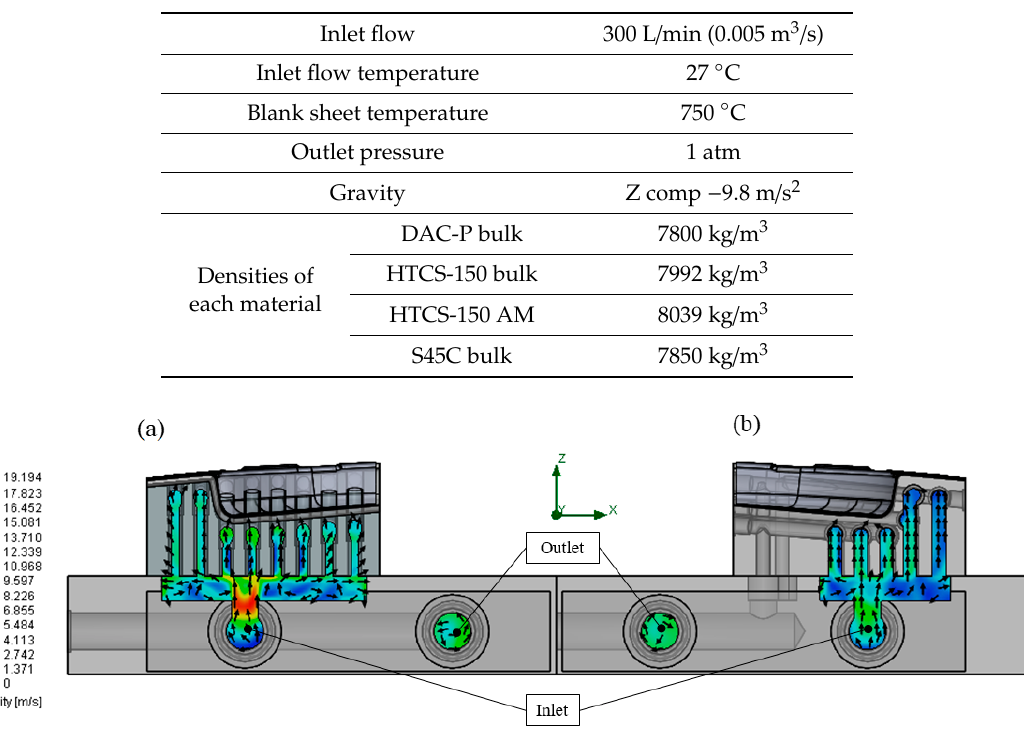
Figure 9. Analysis of cooling-water flow velocity in die due to change in cooling-channel system through continuous thermal-flow analysis in ( a ) conformal cooling channel proposed in this study; ( b ) conventional linear cooling channel.